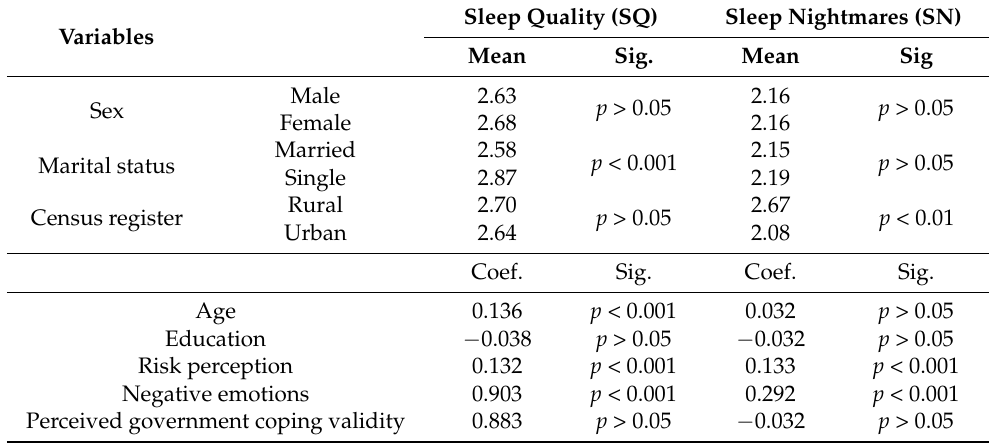
Table 1. Descriptive Results: tabulation and